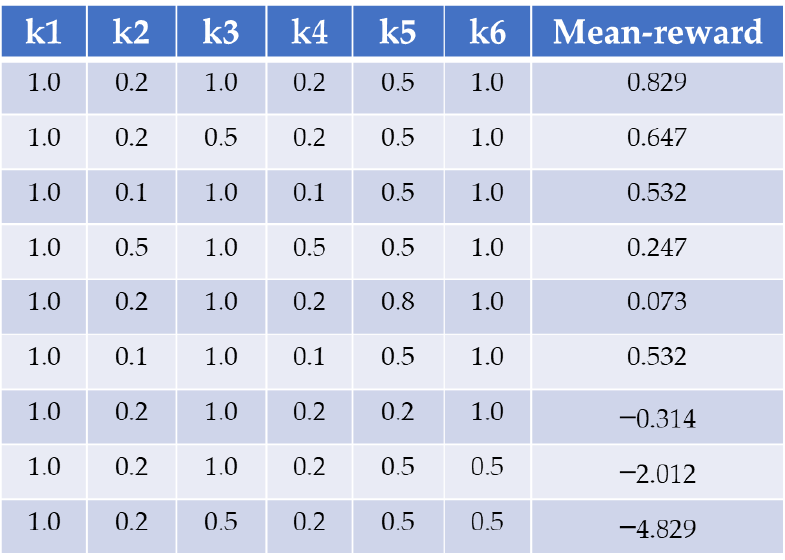
Figure 9. Comparison chart of proportional weights.